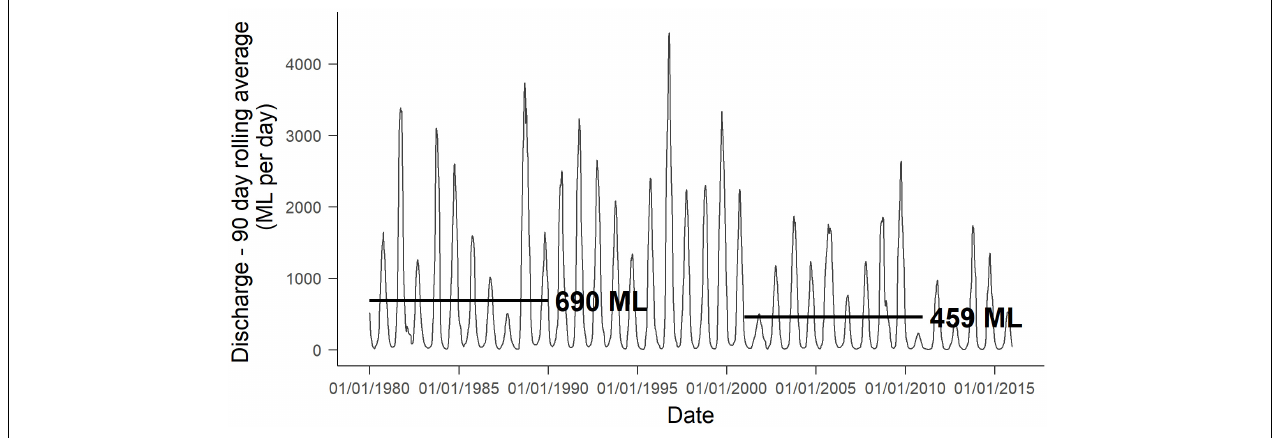
FIGURE 2 | Ninety day rolling mean daily discharge at Barker Road Gauge Station from 1980 to 2016. Black lines indicate mean daily discharge for the two, 10-year periods, 1980 to 1989 and 2001 to 2010 (Department of Water and Environmental Regulation, 2016).